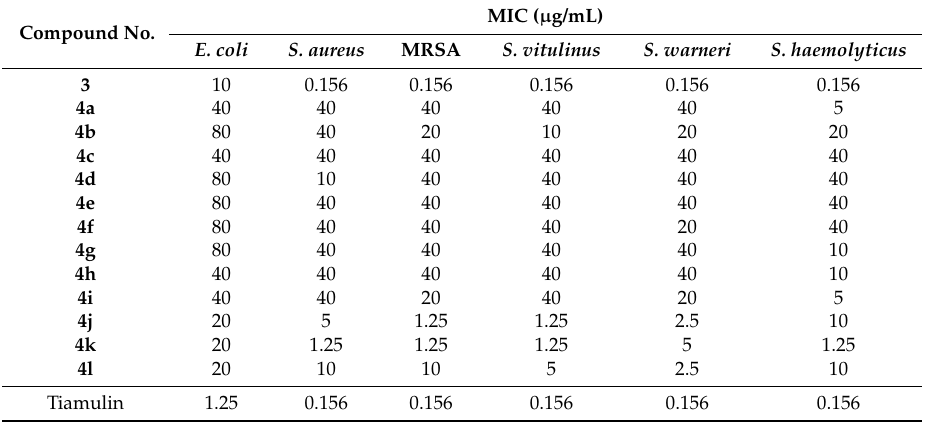
Table 1. In vitro antibacterial activity (MIC) of the synthesized pleuromutilin derivatives. Compound No. Compound